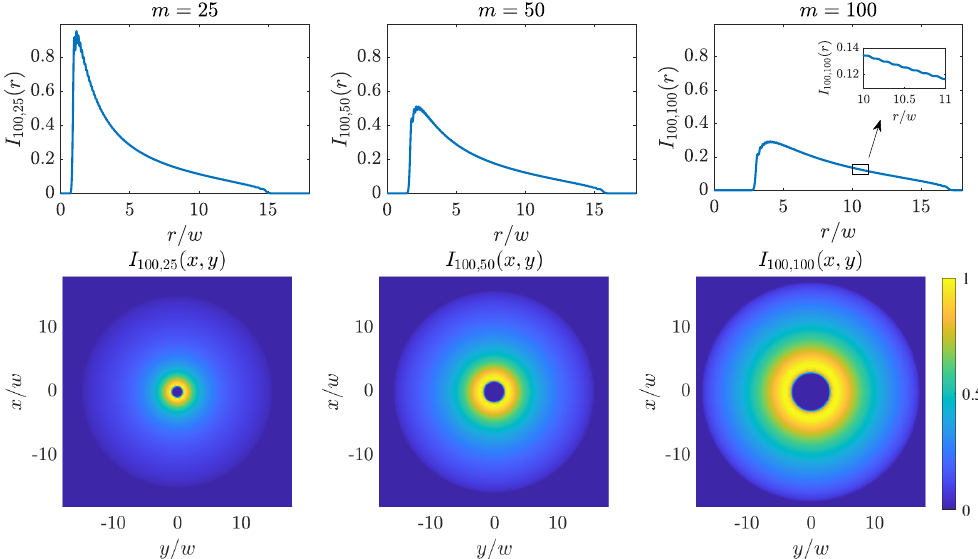
Figure 3. Intensity profiles as functions of the radial coordinate and intensity maps (normalized to its maximum) for N = 100 and m = 25,50,100.